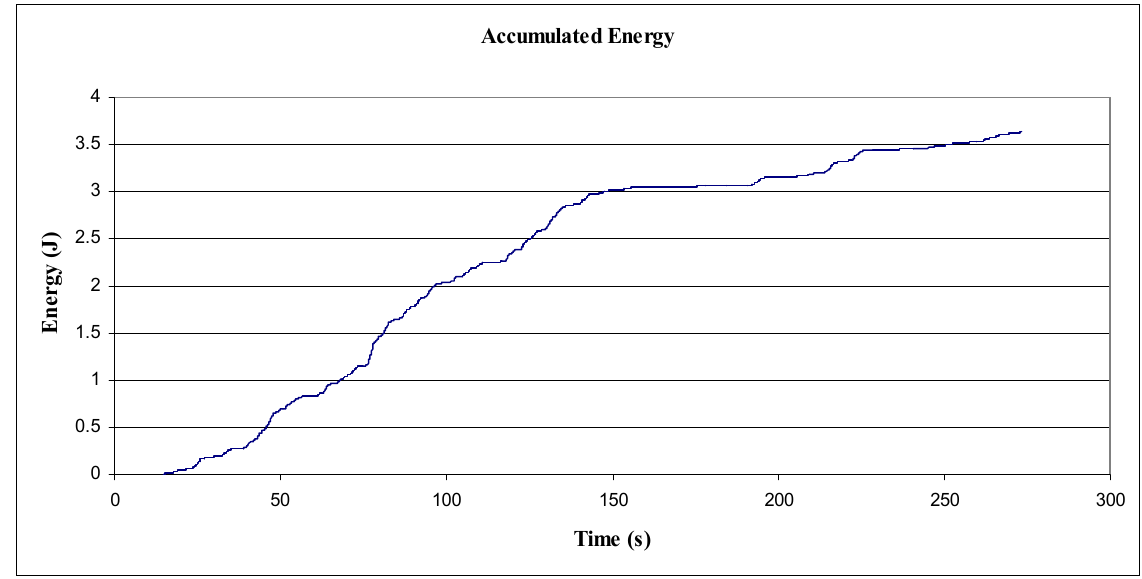
Figure 17. Accumulated Energy (E mass = 5